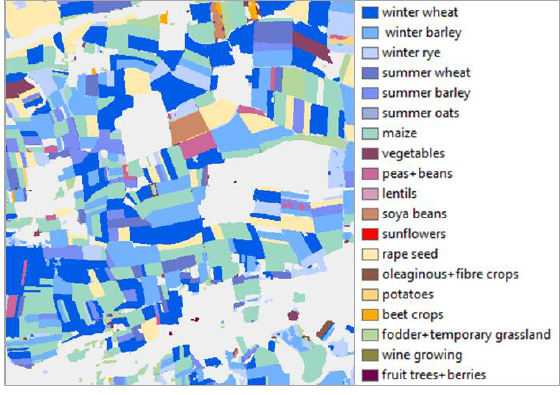
Figure 5. Crop types map 2018